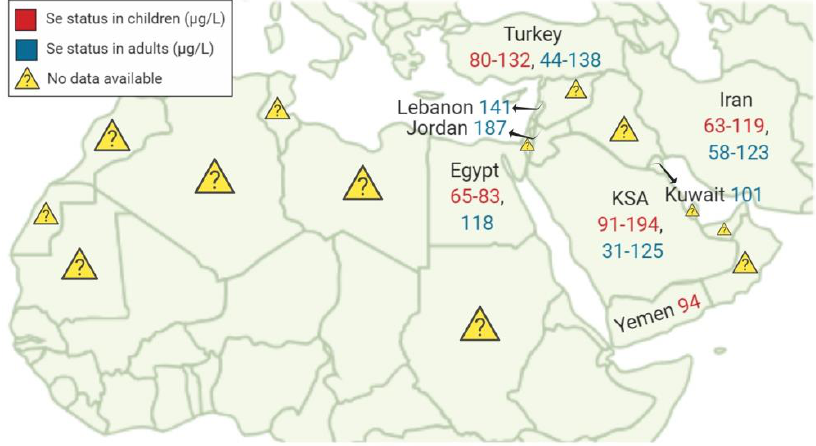
Figure 2. Available data on Se status in children and adults among countries of the MENA region.